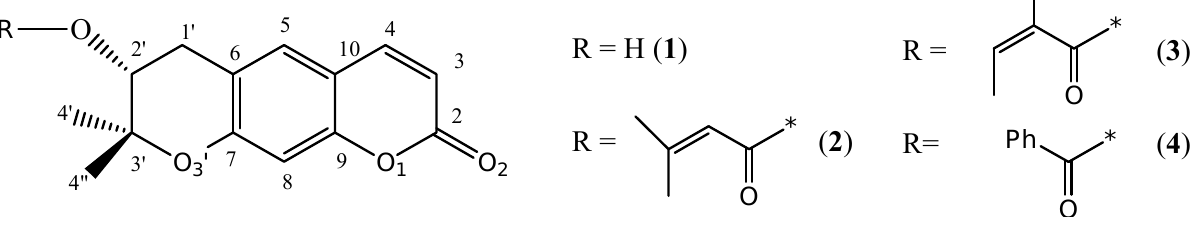
Figure 1. The chemical structure and numbering scheme of